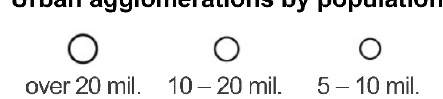
Figure 8. Symbol size legend of the map for Task04 (translated into Figure 8 . Symbol size legend of the map for Task04 (translated into English).